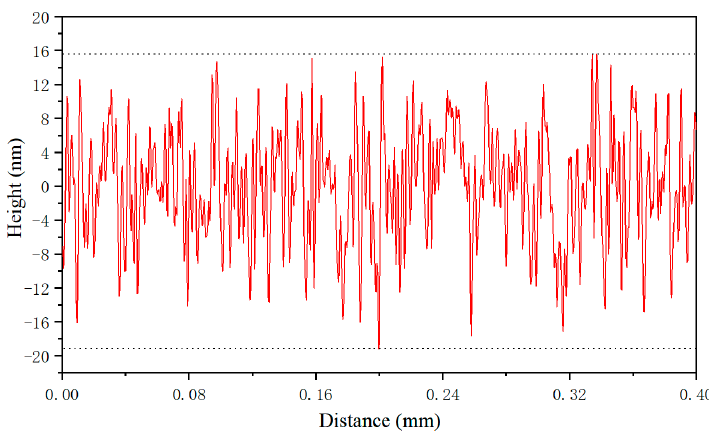
Figure 11. The roughness of microgroove bottom surface.